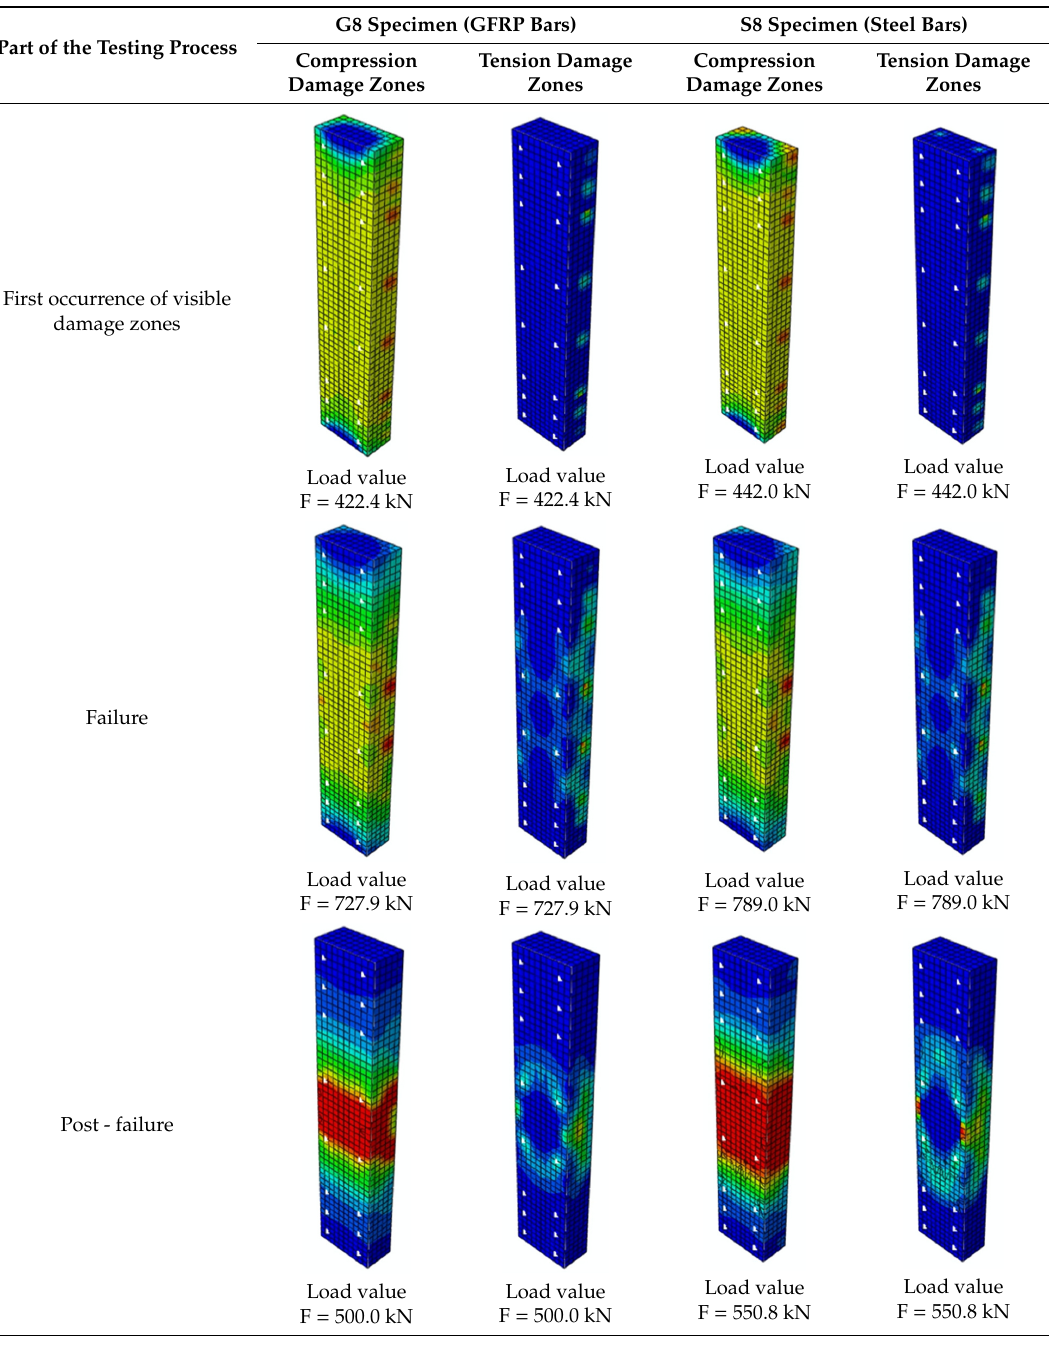
Table 5. Damage evolution simulated in ABAQUS for axially compressed elements (specimens G8 and S8). Part of the Testing Process